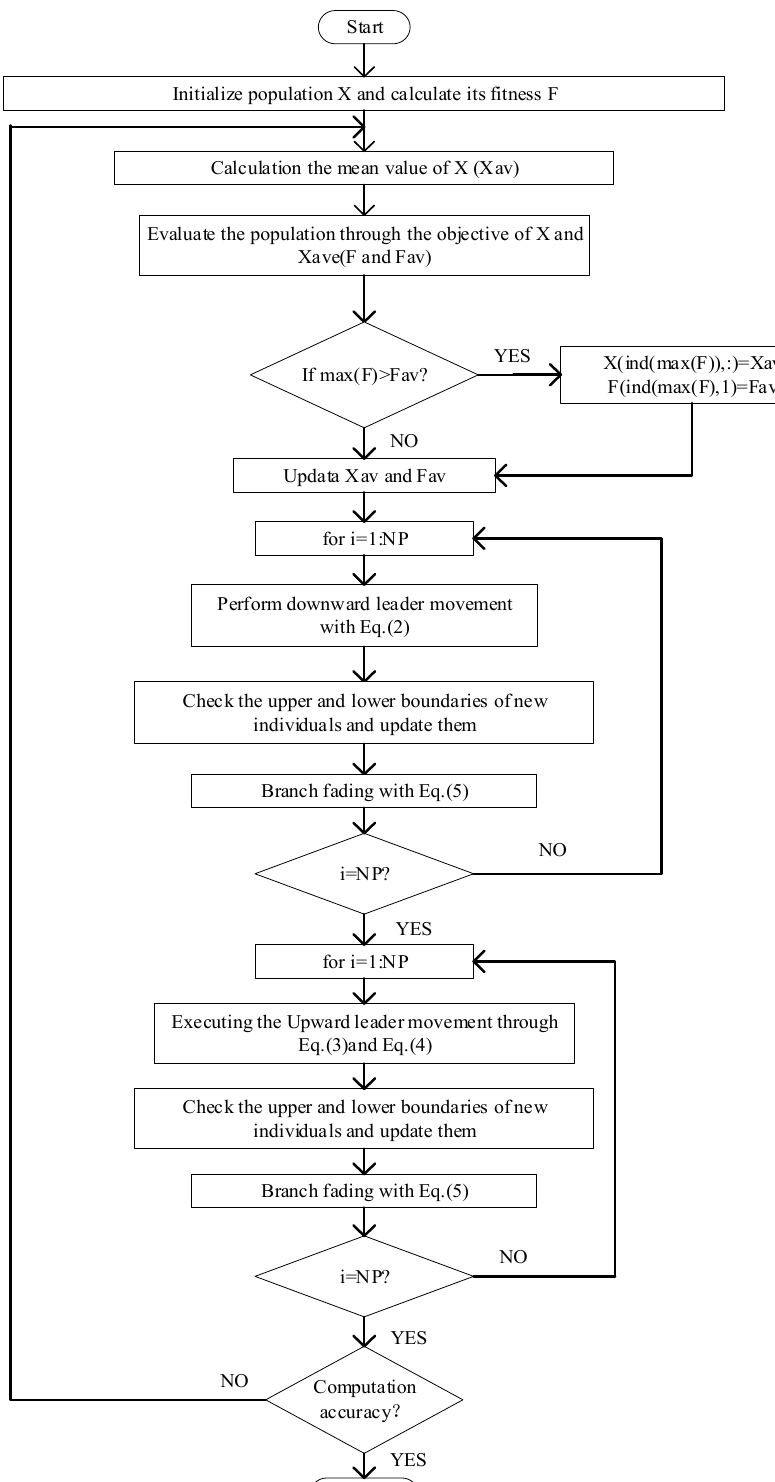
Figure 1. Flow chart of the lightning attachment procedure optimization (LAPO) algorithm.